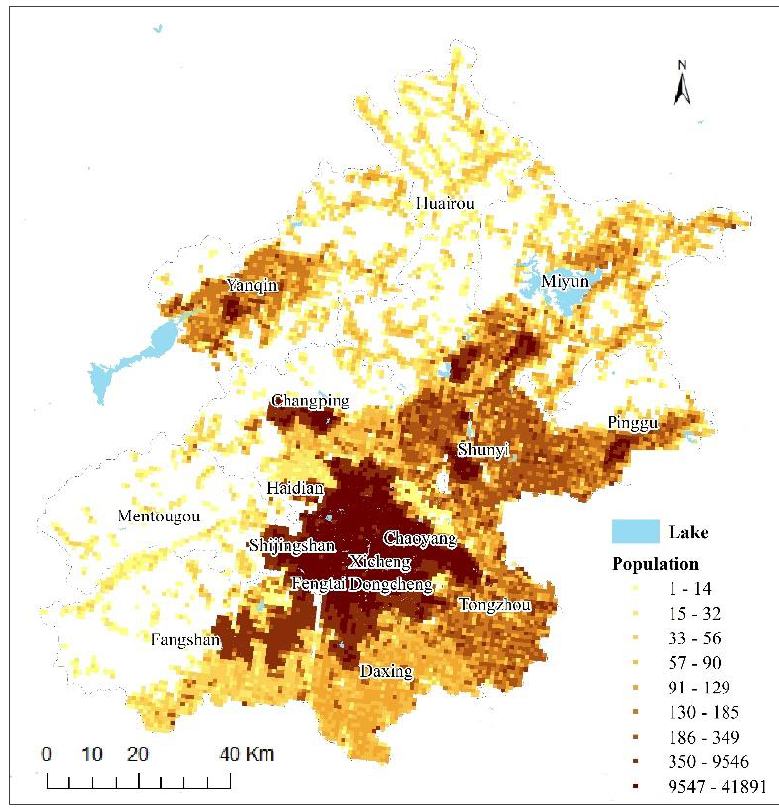
Figure 8. Spatial distribution of population in Beijing.